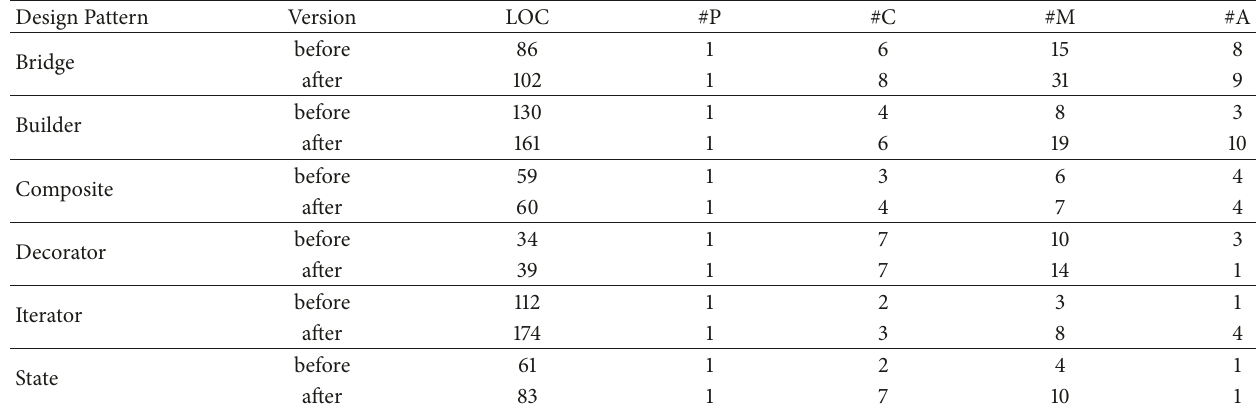
Table 3: Descriptions of the subject software systems.